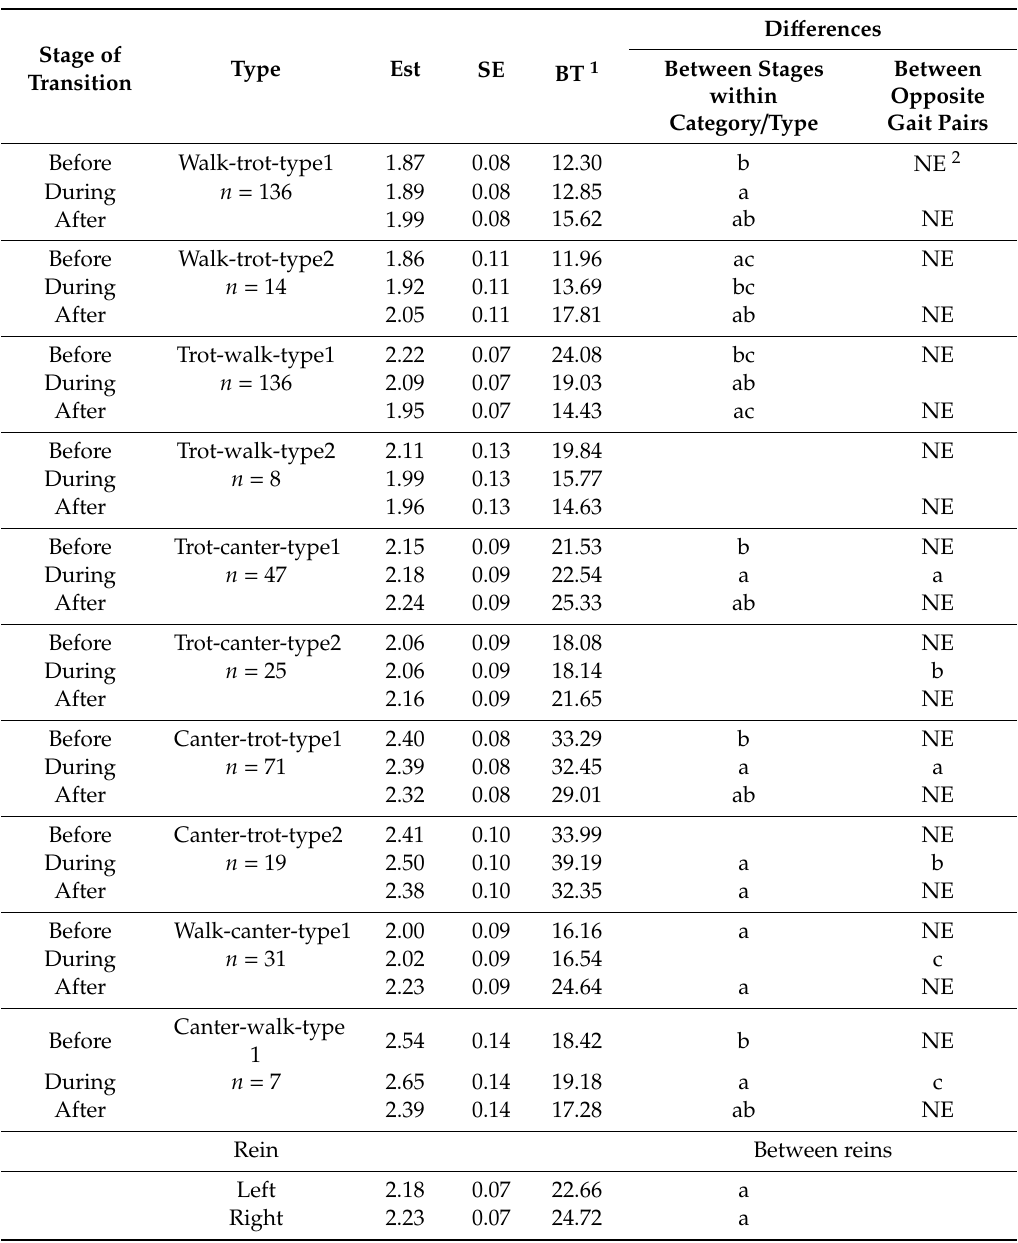
Table 3. Least square means estimates (Est) with standard errors (SEs) for the stage of transition model (model b). The same letters within columns show significant di ff erences ( p < 0.05). There were only 1 transition between canter and walk of type 2, and 1 transition between canter and trot of undetermined type (other), hence comparisons involving these types have been omitted. n = 2769 observations based on 496